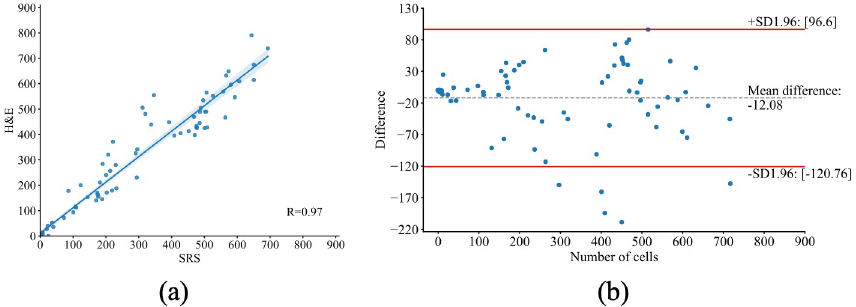
Fig 7. Plot of cell count from SRS and H&E images per FOV. A: Correlation plot. B: Bland-Altman plot.